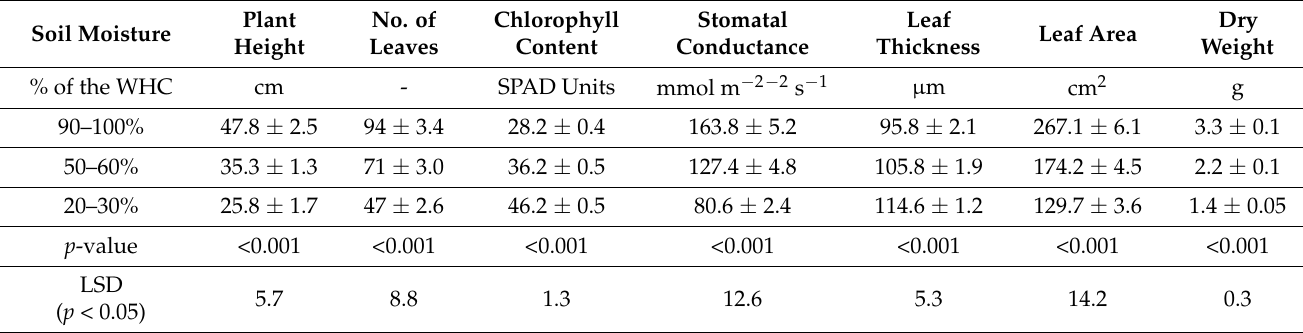
Table 2. Influence of soil moisture regimes on the morpho-physiology and growth of C. truncata , measured at 55 to 60 days after emergence. Data collected from repeated experiments with a total of eight replications per treatment. Soil Moisture